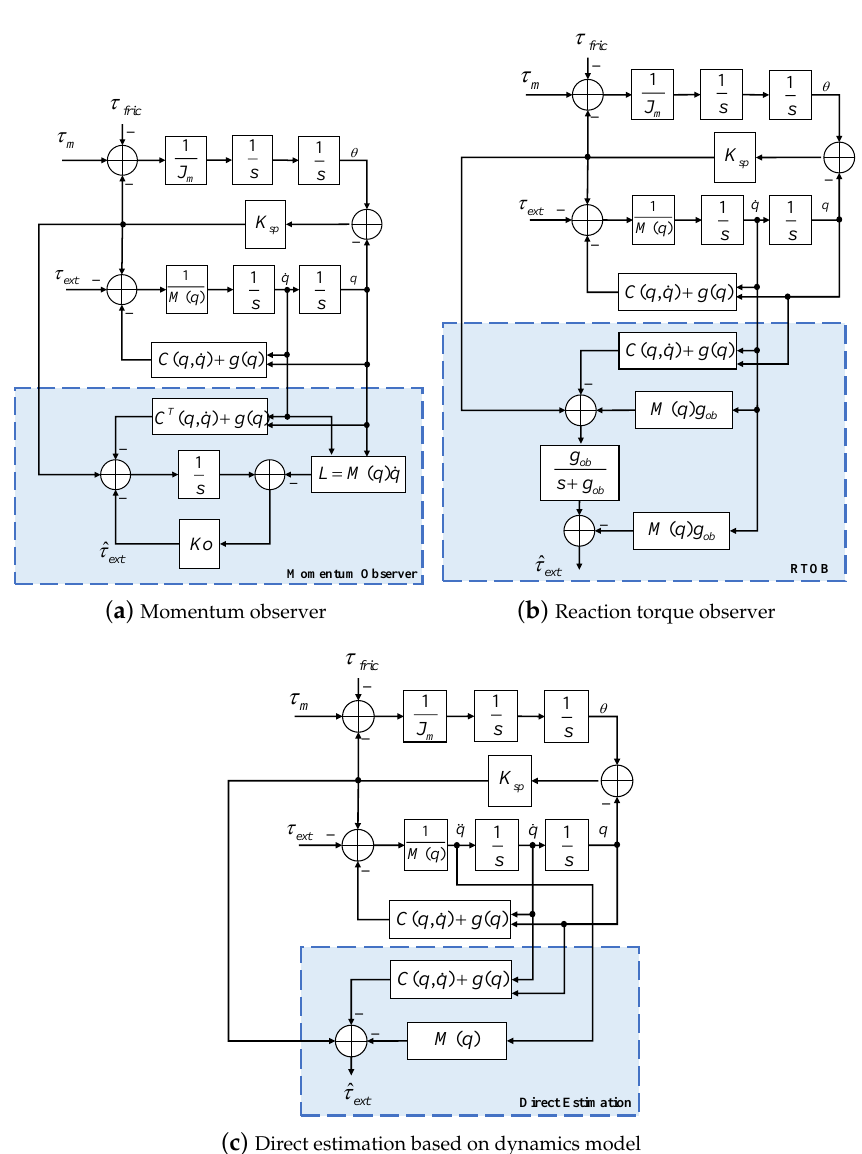
( c ) Direct estimation based on dynamics model Figure 4. Comparison of external torque estimation